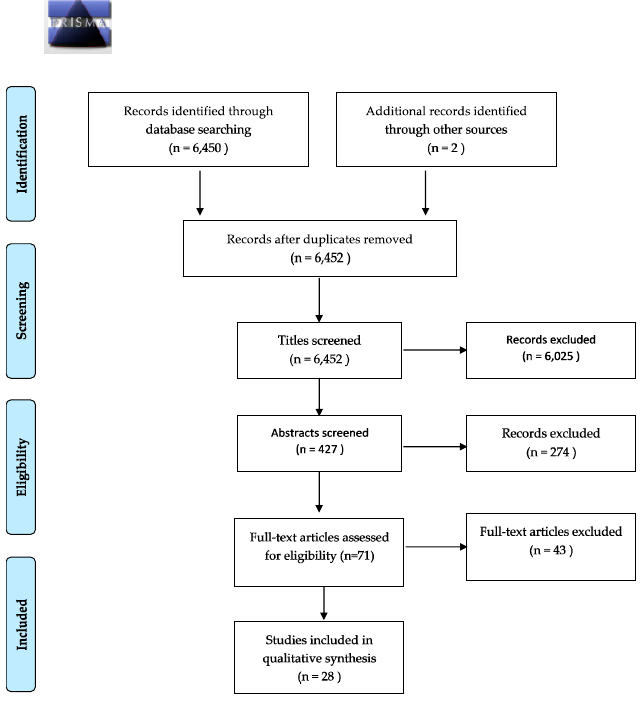
Figure 1. PRISMA flow diagram of study selection